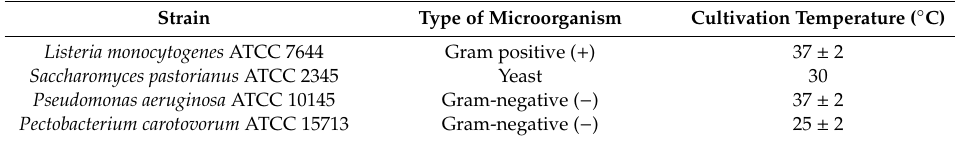
Table 2. The microbial strains and general culture